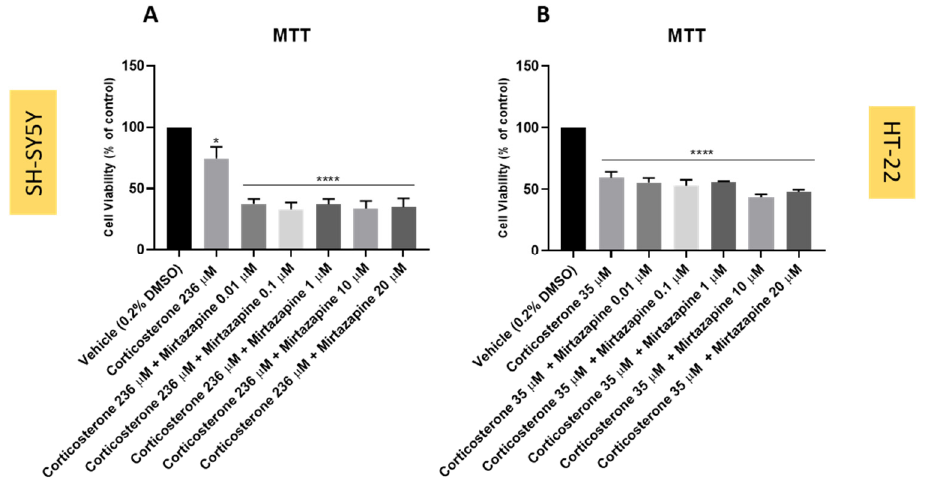
Figure 9. Effect of 48 h-incubation of ( A ) 236 µ M of corticosterone and ( B ) 35 µ M of corticosterone , in combination with 0.01–20 µ M of mirtazapine, determined by MTT assay. The results represent the mean ± SEM of 3–6 independent experiments, expressed as the percentage of the vehicle (100%). Statistically significant * p < 0.05 and **** p < 0.0001 vs. vehicle.